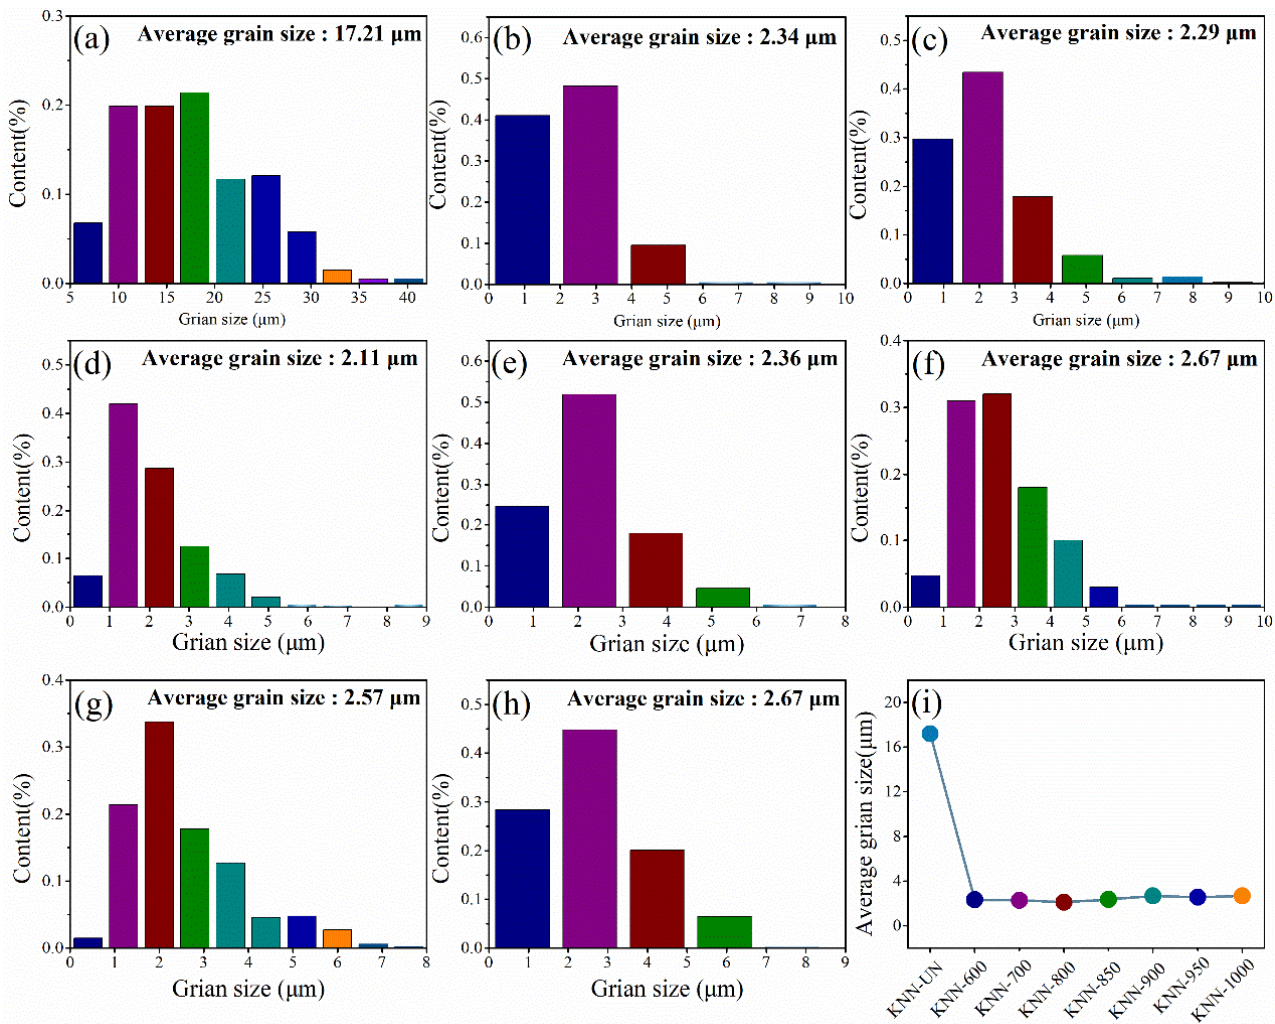
Figure 3. Grain size statistics: ( a ) KNN-UN; ( b ) KNN-600; ( c ) KNN-700; ( d ) KNN-800; ( e ) KNN-850; ( f ) KNN-900; ( g ) KNN-950; ( h ) KNN-1000; ( i ) average grain size distribution of KNN-UN~KNN- 1000 ceramics.